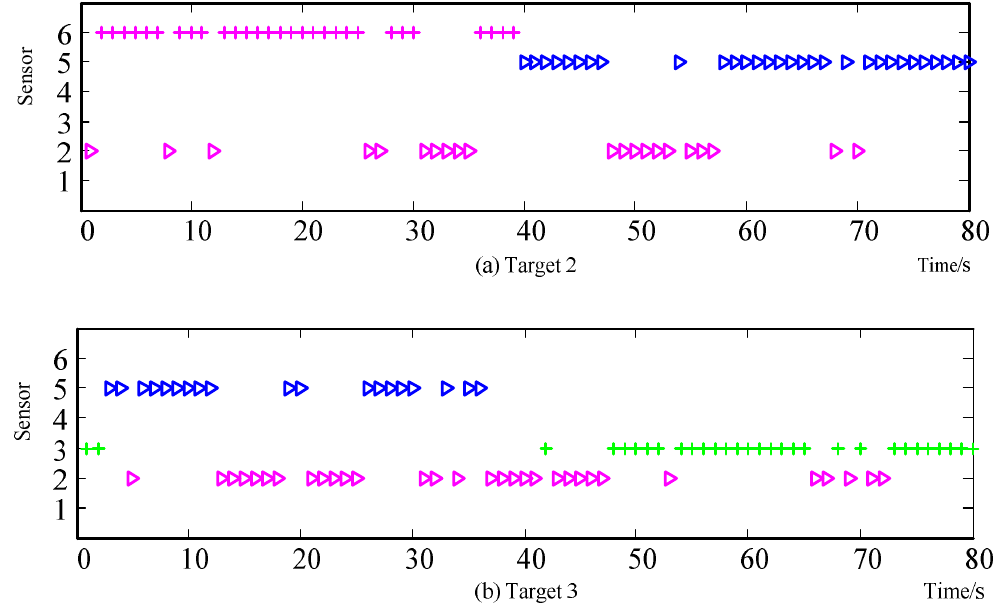
Figure 14. Sensor selected sequences obtained by BDSP. ( a ) Target 2; ( b )Target 3.